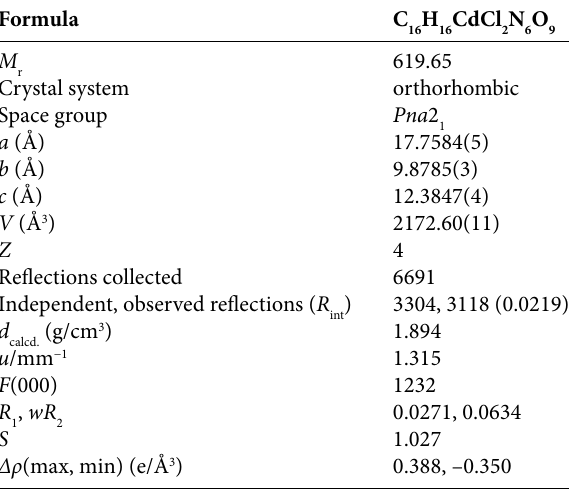
Table 1. Crystallographic data and structural analysis for complex 1